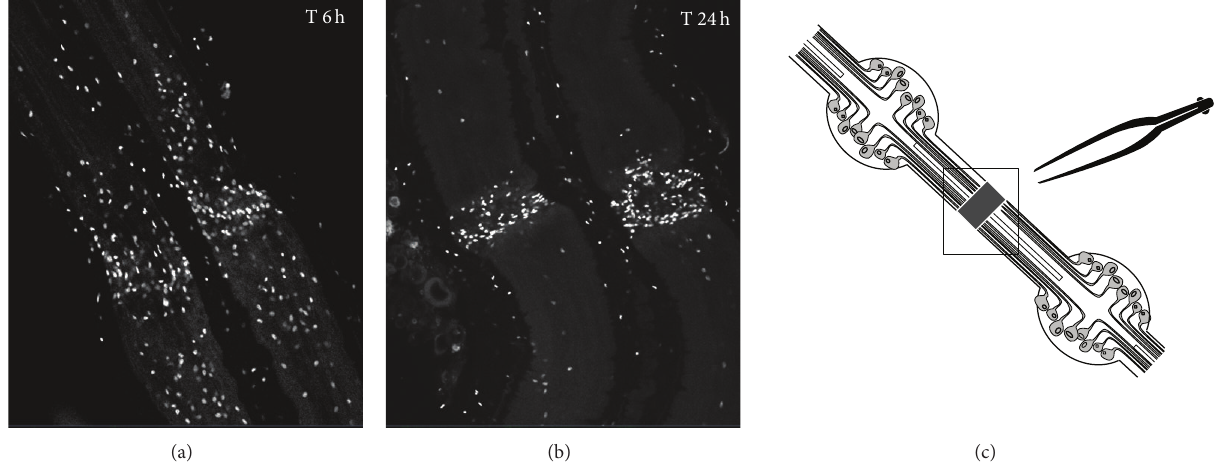
Figure 2: Observation of microglial cell accumulation from isolated and crushed segment of nerve cord maintained in tissue culture (see the diagram (c)). Microglial cell nuclei (white) were stained with Hoechst fluorescent dye to observe cell accumulation at the crush. (a) Six hours following a lesion of connectives, microglial cells progressively migrate toward the lesion site. (b) Later, 24 hours after the crush, microglial cells are mainly recruited to the lesion. This accumulation can be studied as much in vivo as in vitro